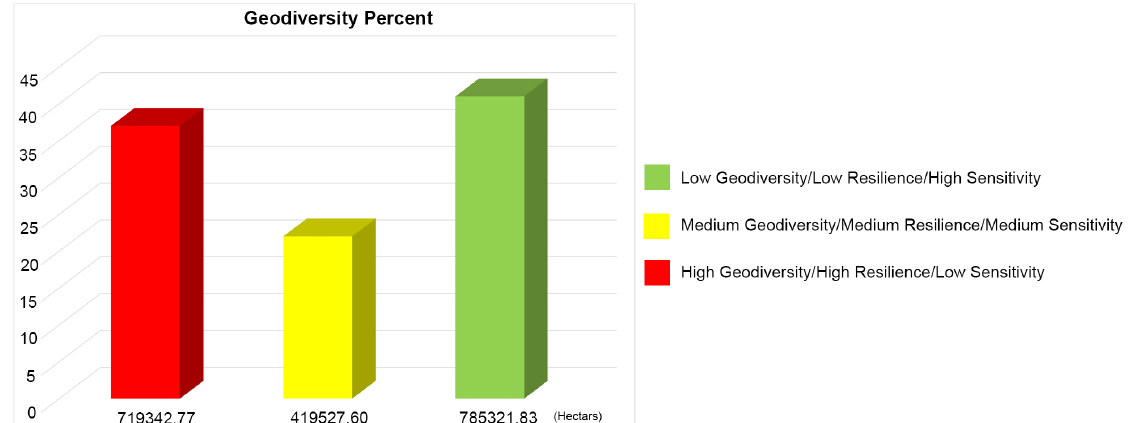
Figure 9. Percentage diagram of the eastern Kopet-Dagh geodiversity (higher geodiversity and resilience indicate lower sen-